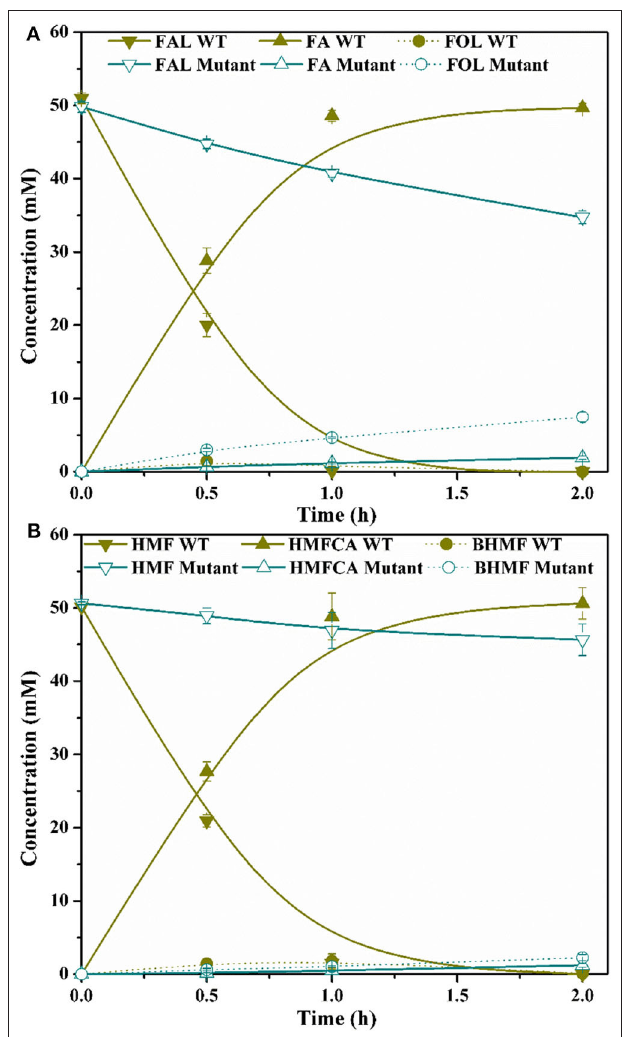
FIGURE 7 | Time course of FAL conversion (A) and HMF conversion (B) by P. putida KT2440 wide-type (WT) and molybdate transporter mutant. Reaction conditions: phosphate buffer (200mM, pH 6.0), 50mM FAL (A) or HMF (B) , 10.5 g/L cells (dry weight), 25mM CaCO 3 , 30 ◦ C, 200